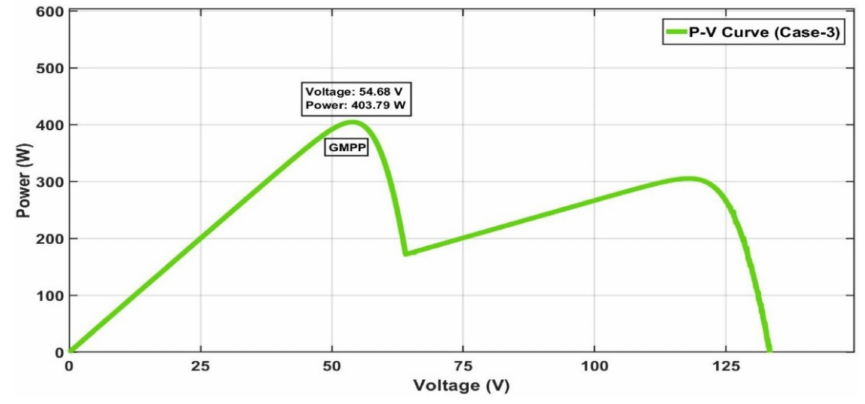
Figure 31. P-V curve (Case-3).